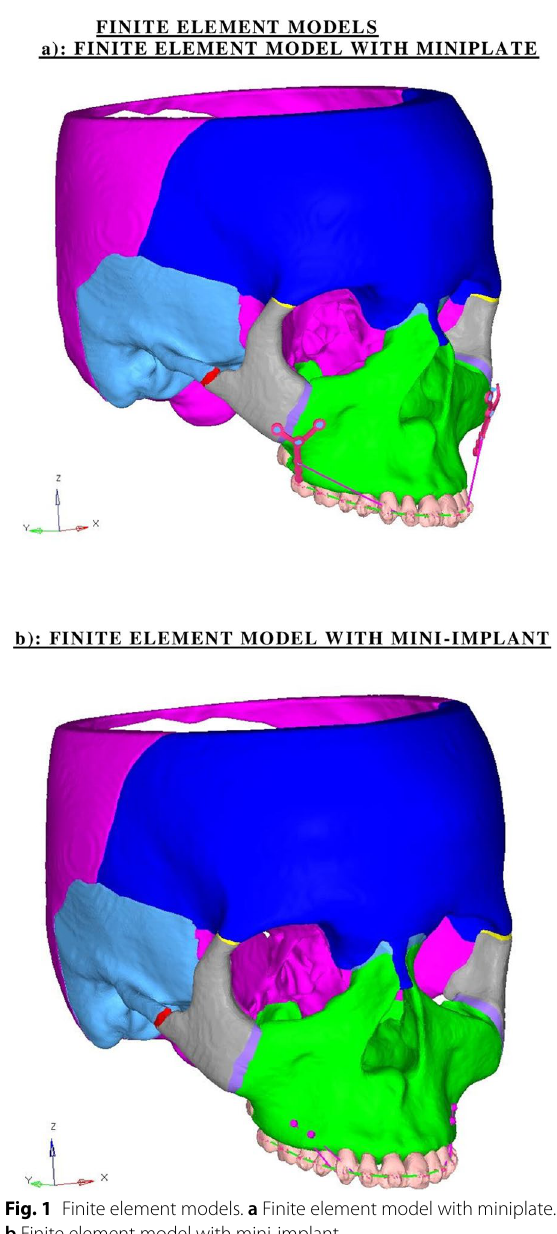
Fig. 1 Finite element models. a Finite element model with miniplate. b Finite element model with